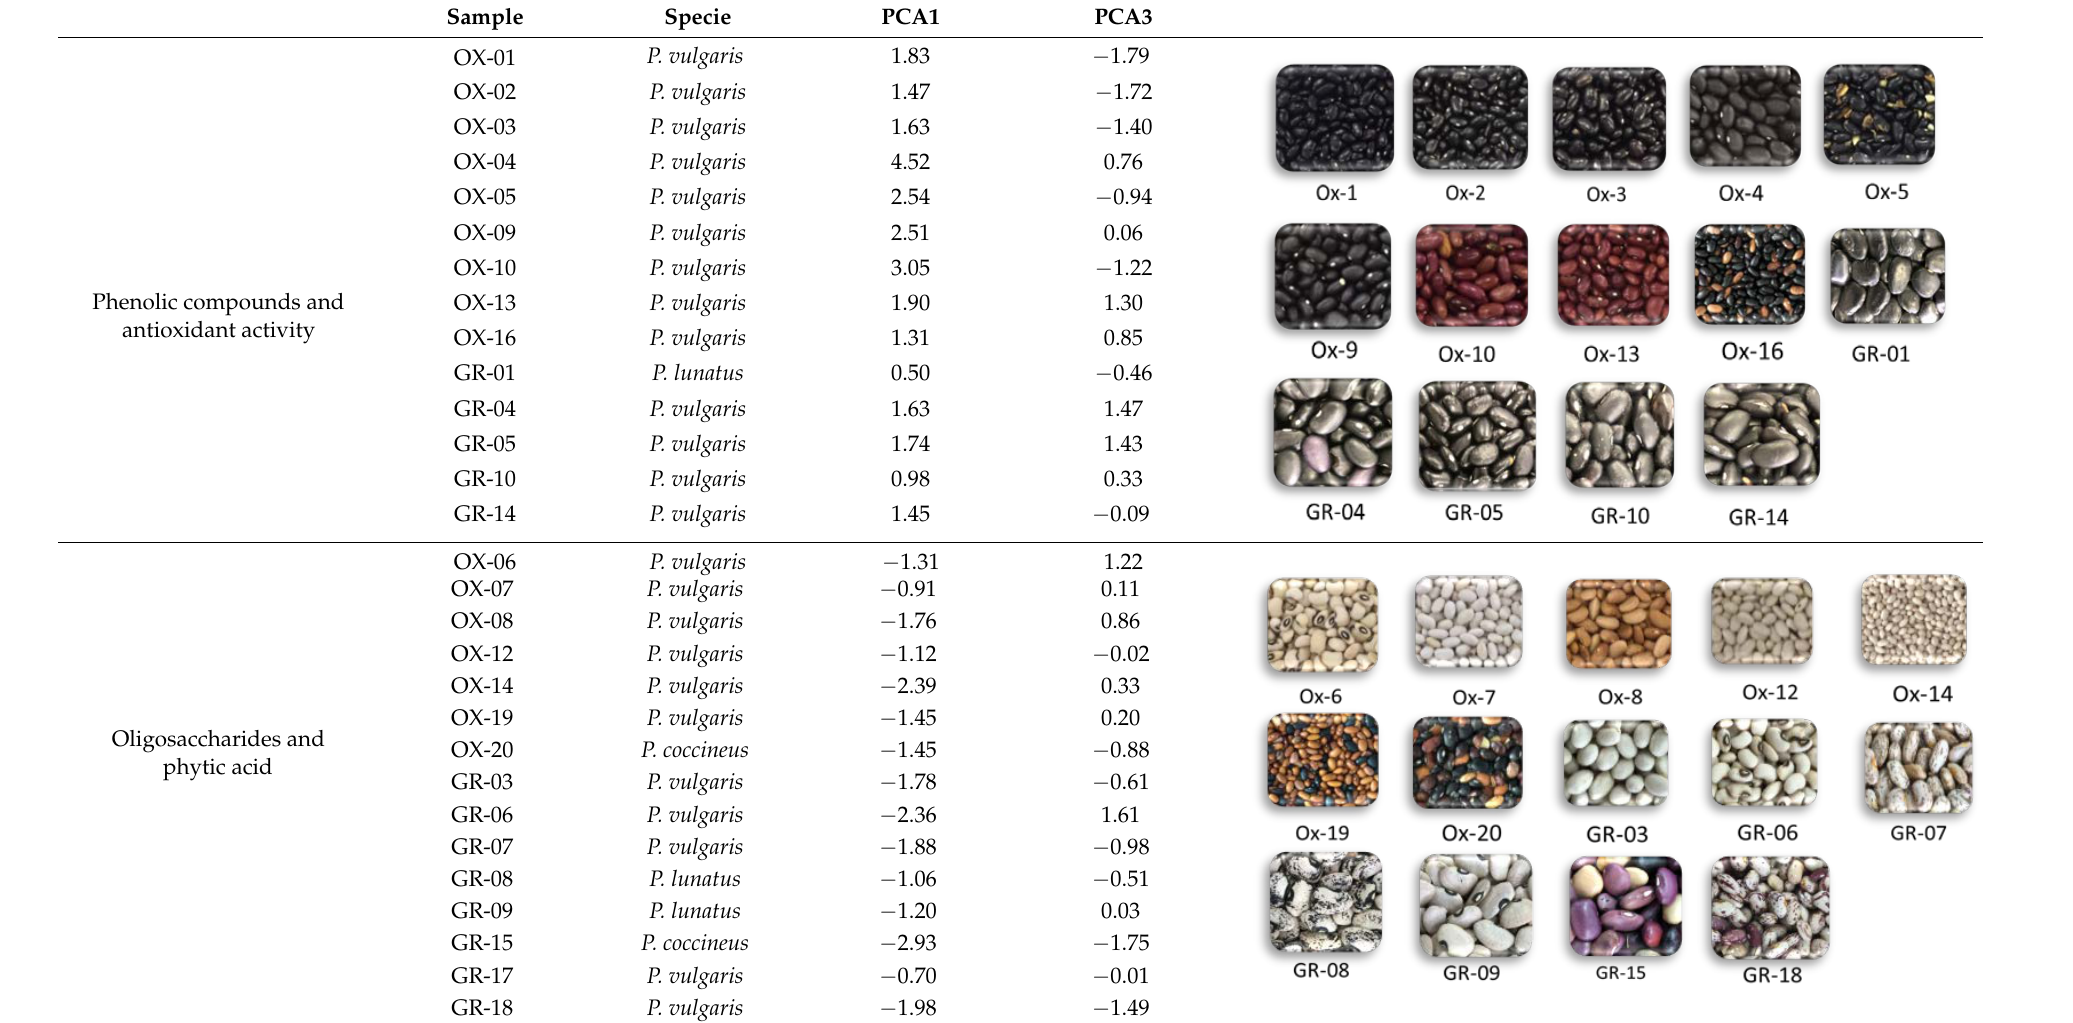
Table 5. Phaseolus accessions group by principal component analysis.